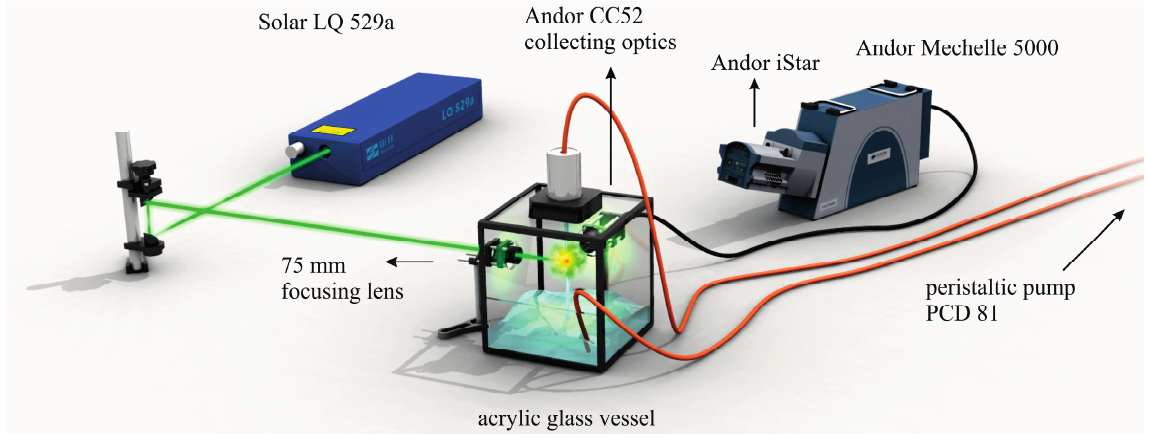
Figure 2. Schematic diagram of the so called liquid LIBS system [60].